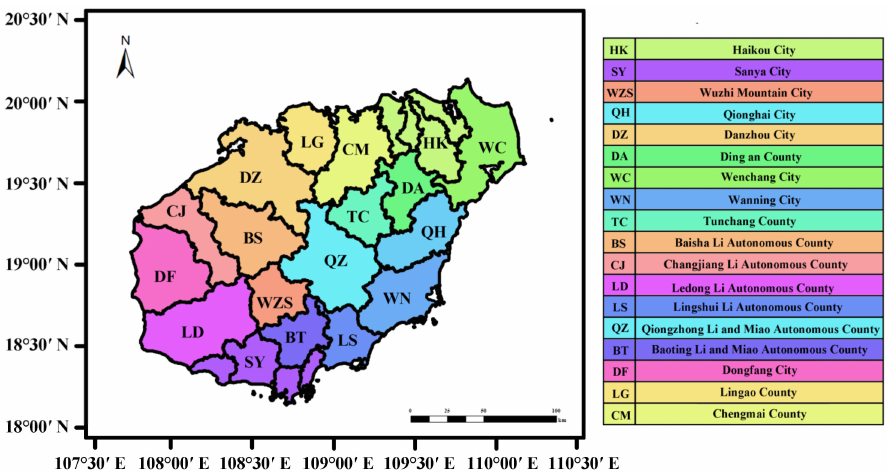
Figure 2. Distribution of cities and counties on Hainan